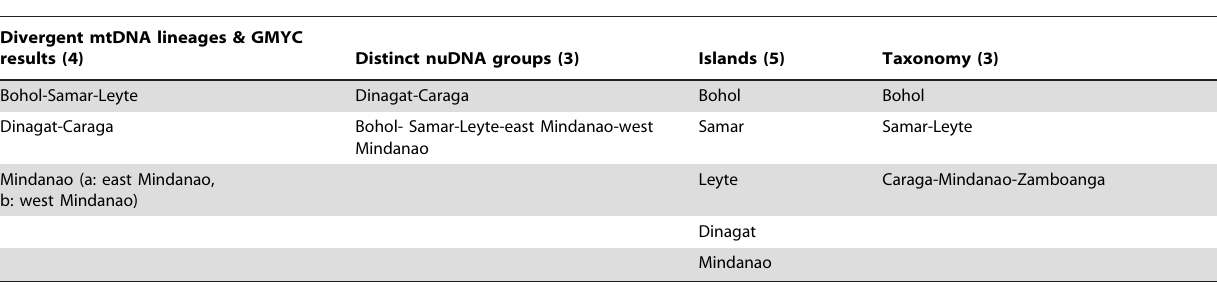
Table 5. Identities by geographical region and numbers (in parentheses) of Philippine tarsier ( Tarsius syrichta ) evolutionary lineages, putative taxa, or conservation targets inferred (new data and analyses) or predicted (biogeography, taxonomy) from each of the five available sources of